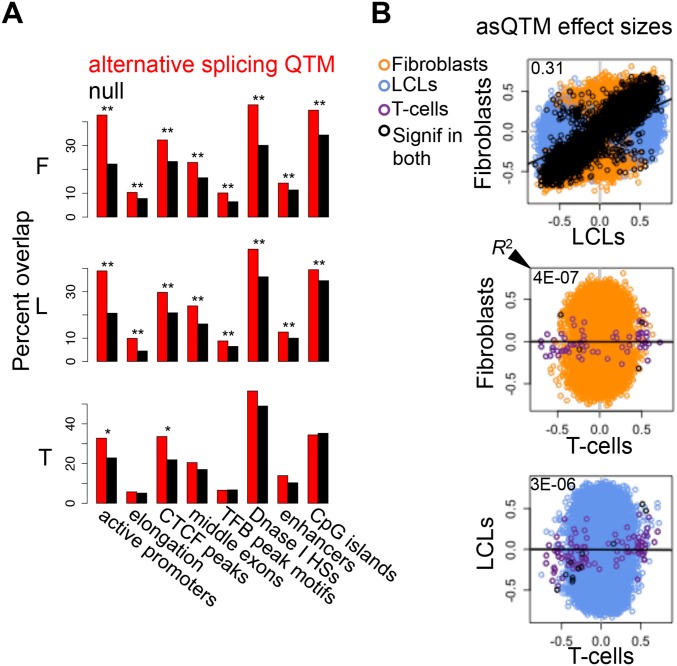
Associations between DNA methylation and alternative splicing.(A) Methylation sites associated to alternative splicing (asQTMs) are significantly enriched for active promoters, elongation marks, CTCF peaks, middle exons, transcription factor binding (TFB) peak motifs, DNase I hypersensitive sites (HSs) and enhancer marks; as shown by the higher percentage of overlap in observed asQTMs compared to null sites. One star indicates P < 0.05, two stars indicate P < 5E-04, Fisher’s exact test (see also S6 Table). For T-cells there was no ChIP-seq data available at the time of analysis so the data of an LCL was used instead (see Materials and Methods). (B) Effect sizes of the union of asQTMs (best methylation site per exon-exon link) for each pair of cell-types are plotted. Effect size is measured as the slope of the linear regression of alternative splicing levels given methylation levels on scaled values. Hence, effect sizes are quantified in terms of number of alternative splicing standard deviations changed by every methylation standard deviation change. Black dots depict associations significant in both cell-types compared; orange, blue and purple dots are associations significant in only fibroblasts, LCLs and T-cells, respectively, within each pair compared. Coefficient of determination R2, reflecting the proportion of effect size variance in one cell-type explained by the other cell-type, is shown in the top left corner of each plot (S1 Table). Given lower sample size in T-cells, there are many less significant associations and hence, it is difficult to assess cell-type specificity between this cell-type and the rest. Fibroblasts and LCLs show a significant fraction of shared correlations between DNA methylation and alternative splicing, and also a high abundance of tissue-specific effects.